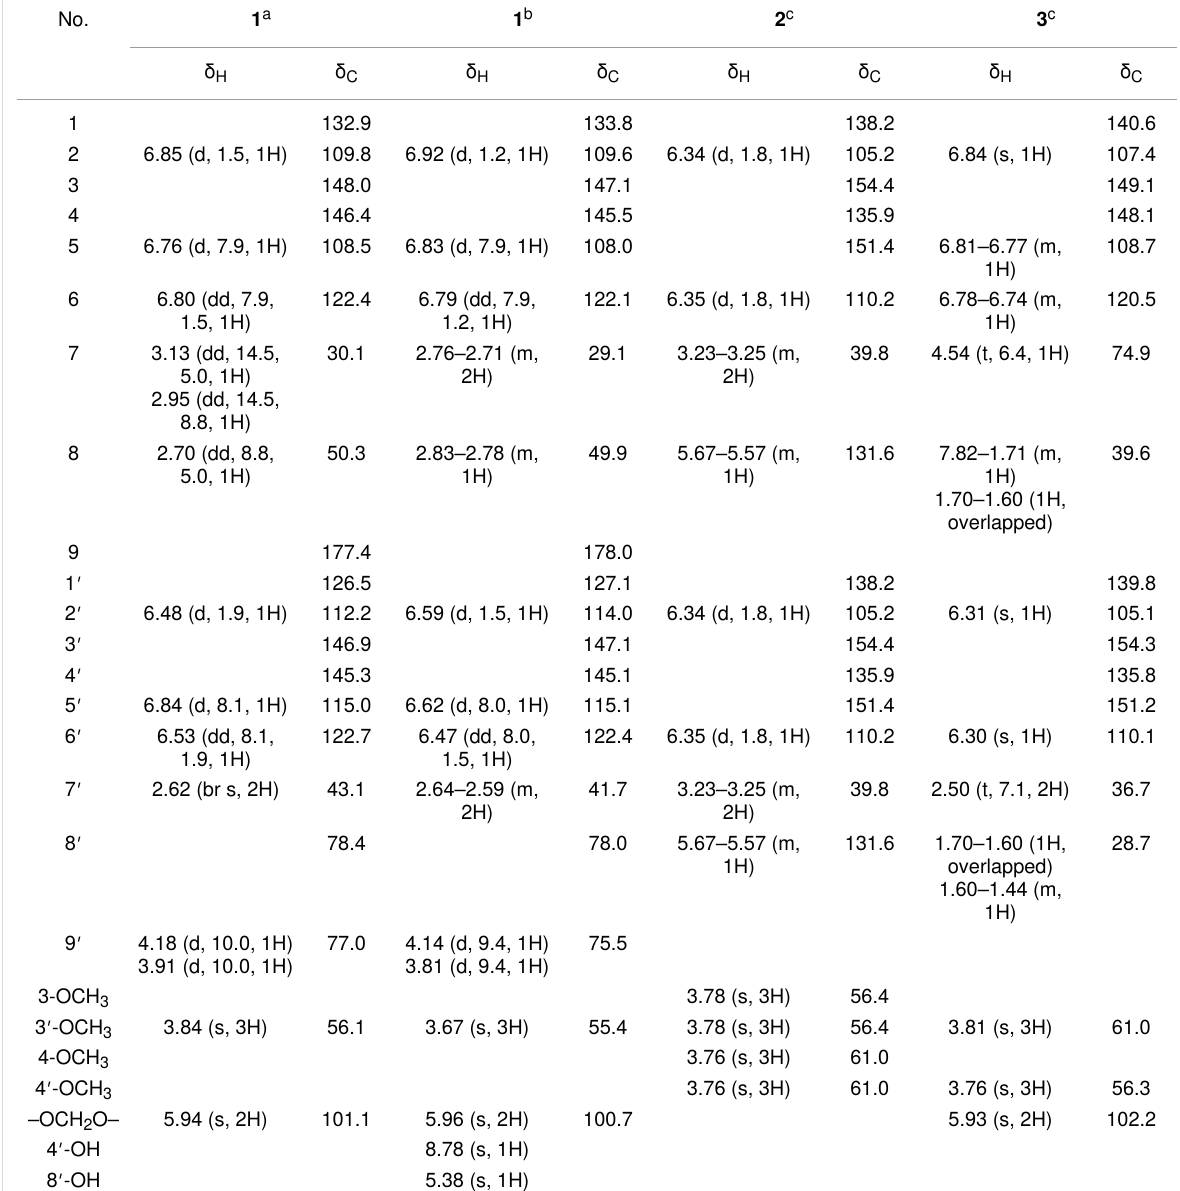
Table 1: 1 H NMR and 13 C NMR data of compounds 1 – 3 ( δ in ppm and J in